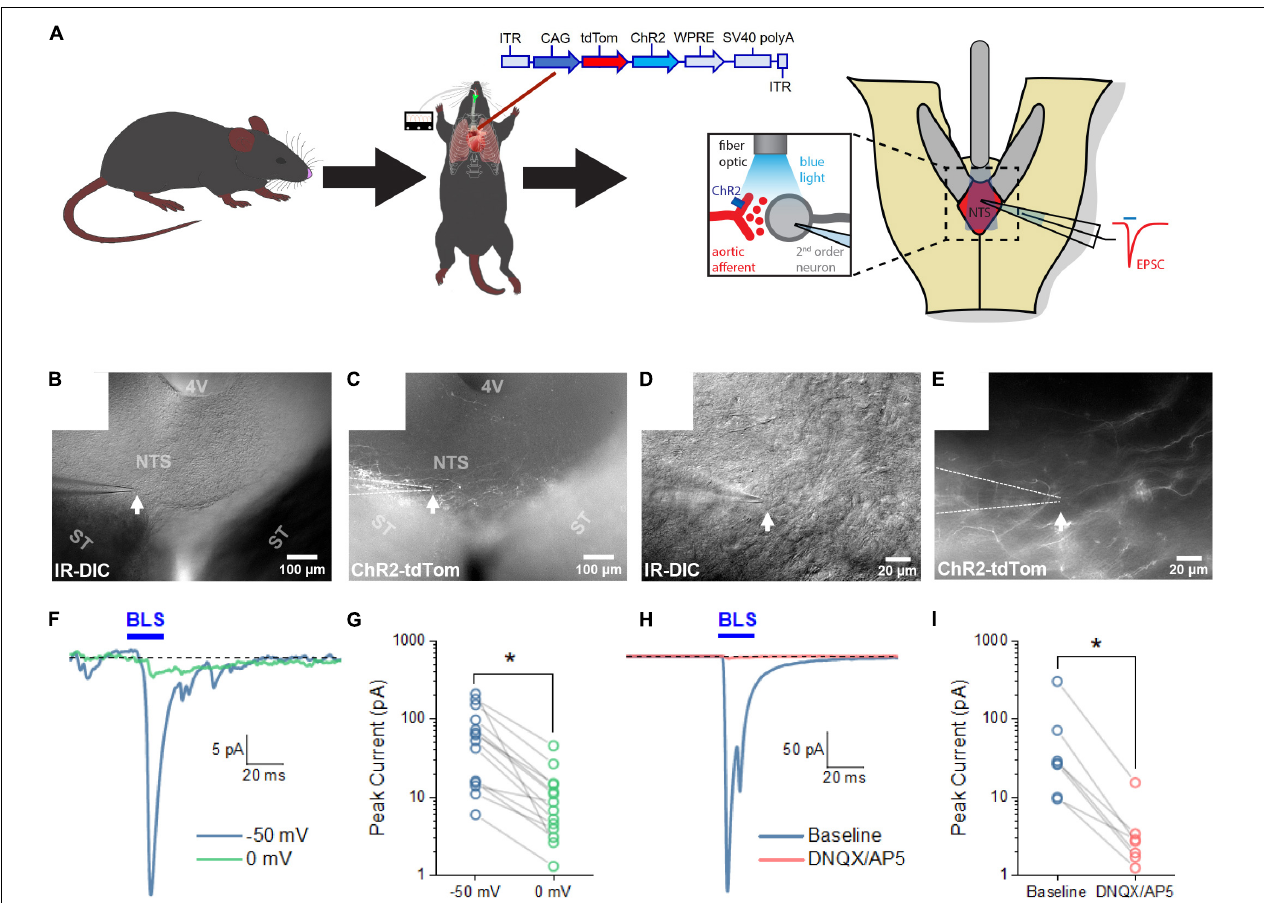
FIGURE 5 | Blue light stimulation of baroreceptors induces glutamate release onto NTS neurons. (A) AAVrg applied to the aortic arch to direct the expression of ChR2 and tdTom within sensory neurons innervating the aortic arch ( n = 7). Light-sensitive synapses in the NTS were characterized using whole-cell patch-clamp in horizontal brain slices. (B–E) Neurons in close approximation with ChR2/tdTom axons were targeted for study using a combination of infrared differential interference contrast (IR-DIC) and epifluorescence microscopy. (F) Representative traces from an NTS neuron demonstrating an excitatory current produced by 20 ms blue light stimulation (BLS). Light-evoked currents were substantially reduced when neurons were voltage clamped at 0 mV. Traces shown are the mean of 10 consecutive sweeps. (G) Mean peak light-evoked inward current at -50 and 0 mV ( n = 14 cells from seven animals). (H) Representative traces demonstrating light-evoked inward current is also strongly attenuated by bath application of glutamate receptor antagonists. Traces shown are the mean of 30 consecutive sweeps. (I) Light-evoked currents were significantly reduced by ionotropic glutamate receptor antagonist ( n =